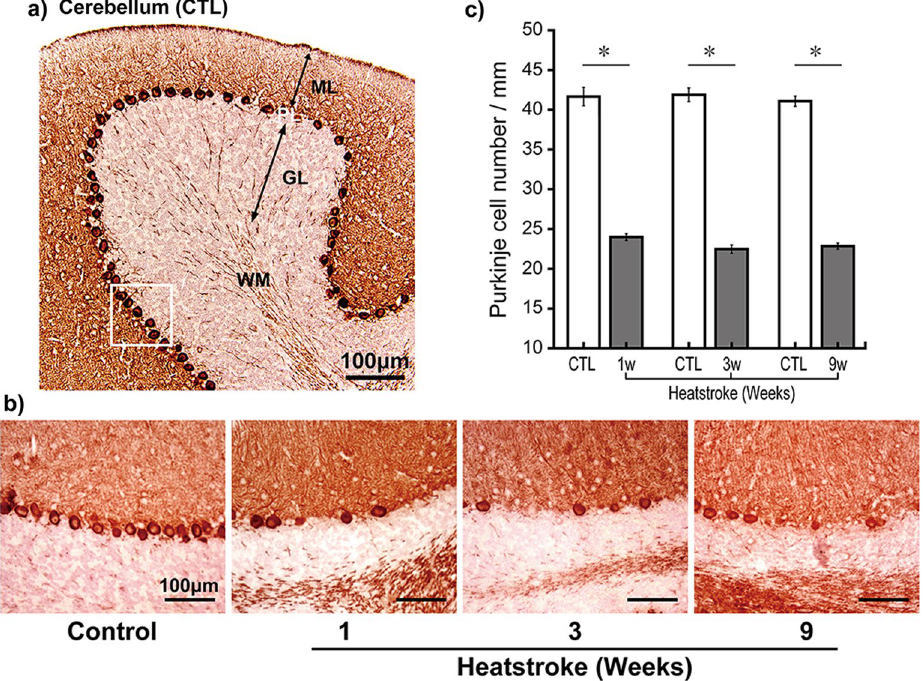
Figure 3. Purkinje cell number significantly decreased after heatstroke. To assess Purkinje cells, calbindin was immunostained in the brain and the calbindin-positive Purkinje cell numbers were counted. ( a ) Representative image of calbindin-immunoreactions in the cerebellum. Calbindin-immunoreactions stained the soma of Purkinje cells, the dendritic fibers that were widely stained in the molecular layer (ML), and the white matter. ( b ) Higher magnification images of the Purkinje cell layer in the control (CTL; left) group from 1 to 9 weeks after heatstroke. Purkinje cells in the CTL animals were aligned in an equidistant manner. However, the number of cells decreased after heatstroke. ( c ) The Purkinje cell numbers of the HS group were significantly decreased during the experimental periods after heatstroke (1, 3, and 9 weeks, n = 9, respectively) compared with the CTL group (n = 9). Data are expressed as means ± SD (* P < 0.05, Student’s t test). ML molecular layer, PL Purkinje cell layer, GL granular cell layer, WM white matter, SD standard